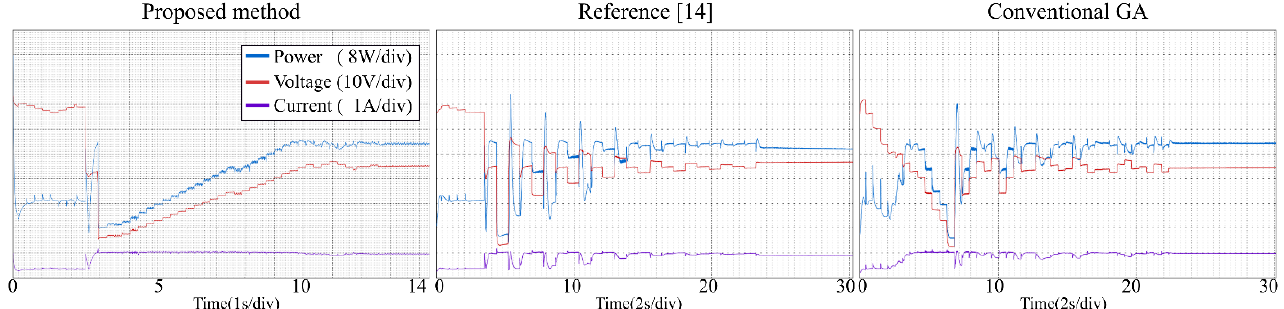
Figure 12. The P-V curves of six test patterns.